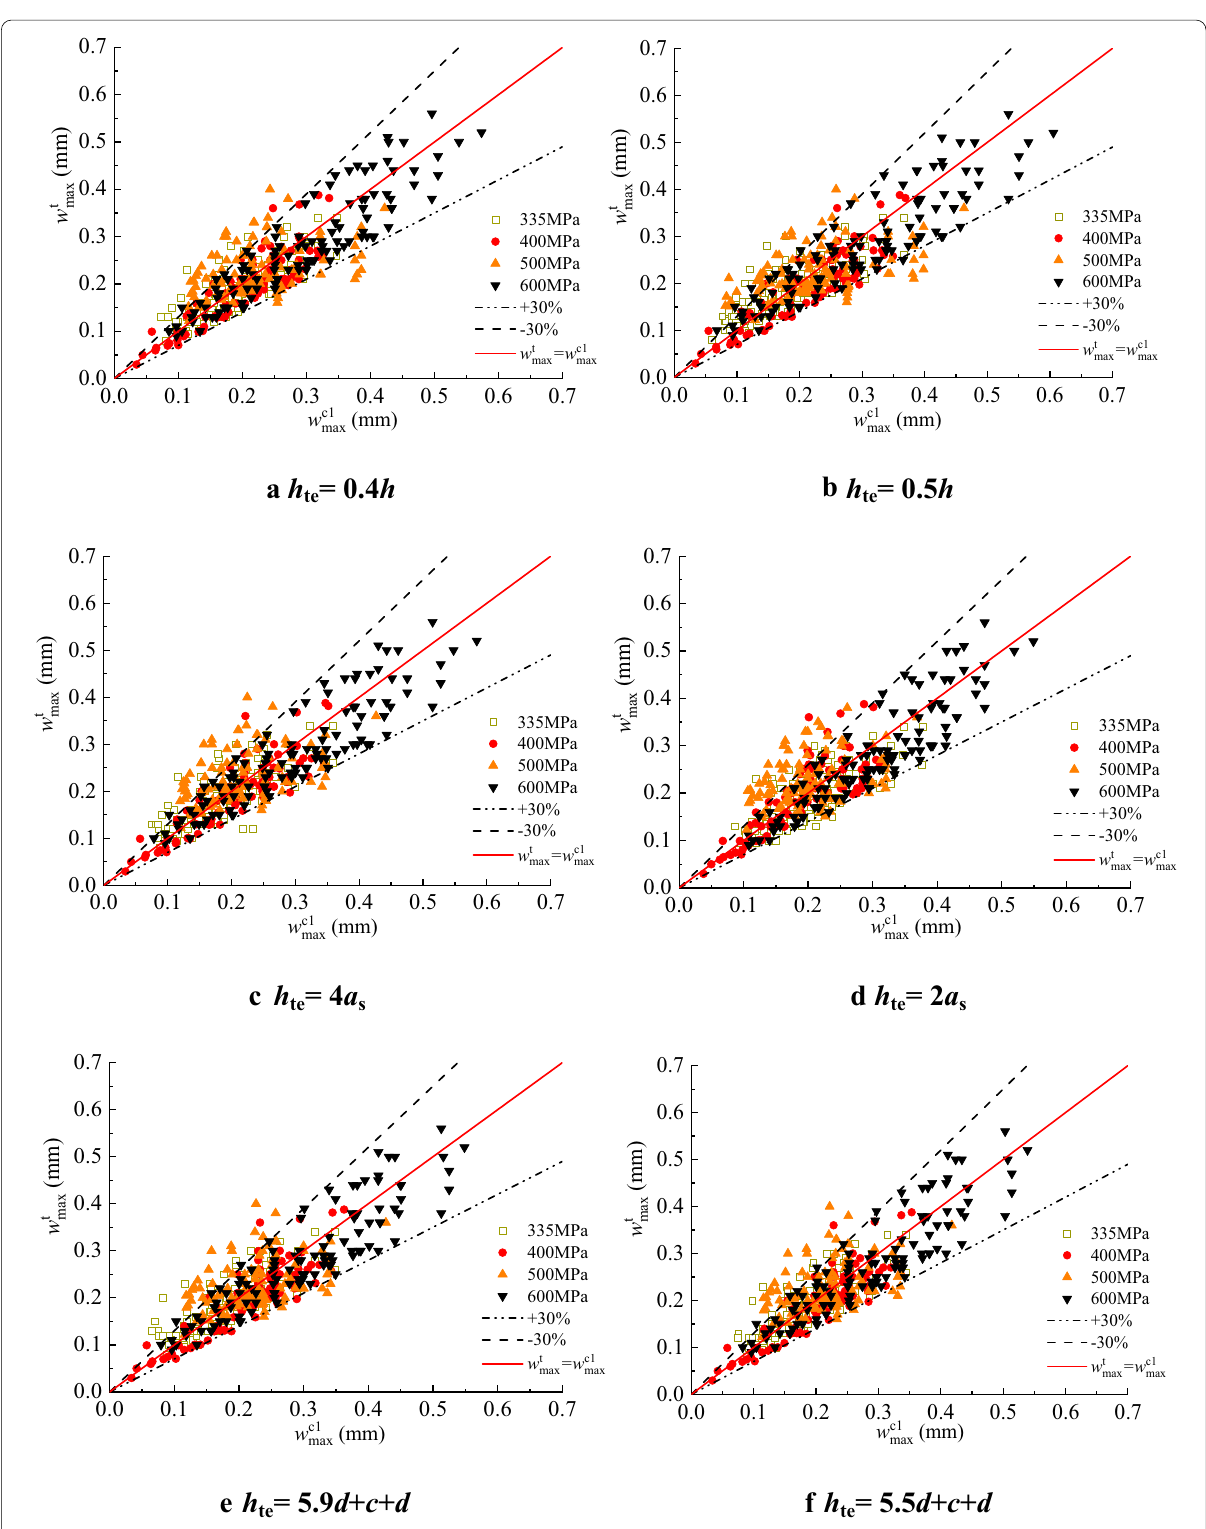
Fig. 19 Comparison of experimental w t max from RC beams with 335 MPa to 600 MPa steel bars with calculated w c1 max by the proposed